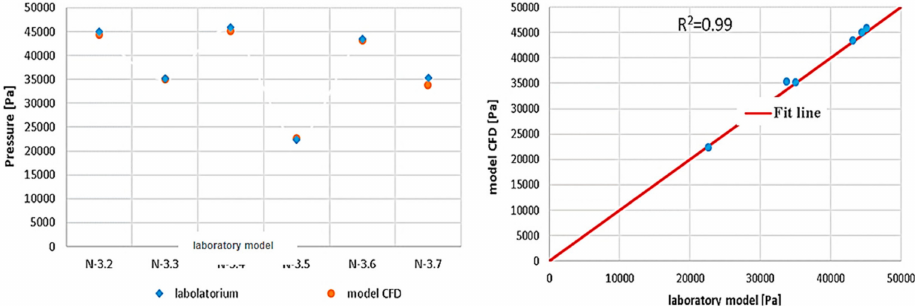
Figure 7. Comparison of pressure values obtained from the CFD model with the results obtained from the